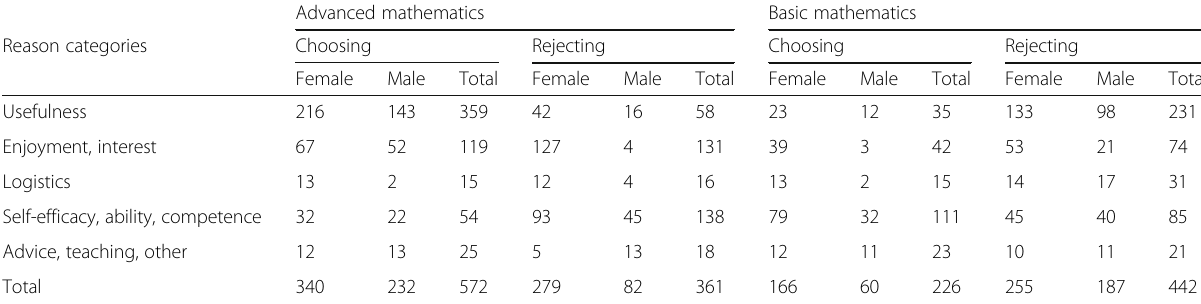
Table 3 The upper-secondary school students ’ reasons for choosing or rejecting